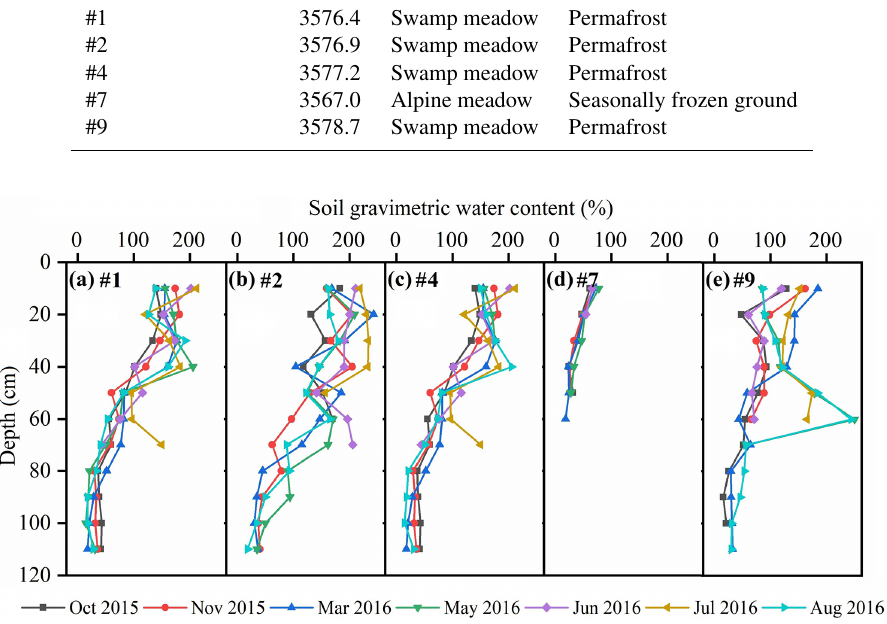
Figure 8. Soil gravimetric water content at five sampling sites (#1, #2, #4, #7, and #9) from October 2015 to August 2016 at the Mahan Mountain permafrost region. The location and information of the sampling sites are shown in Fig. 1b and Table 3, respectively.